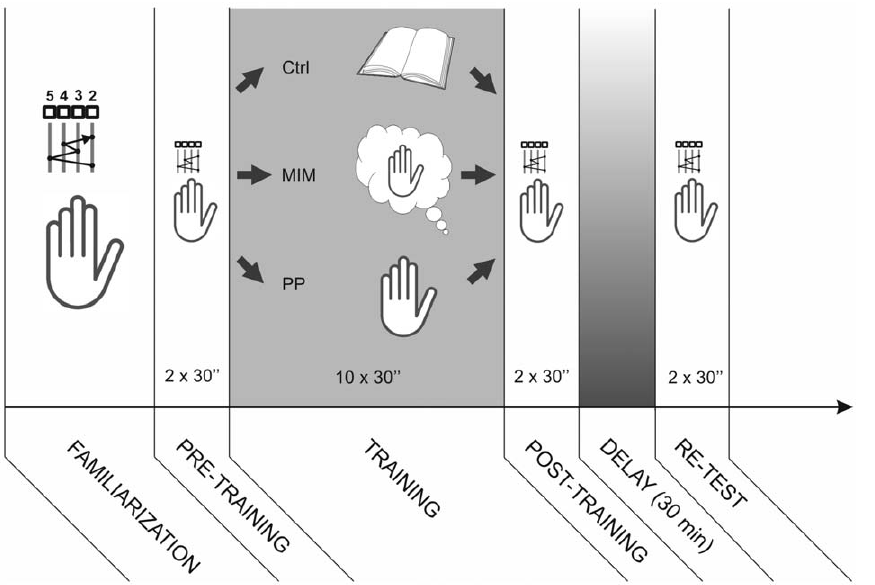
Figure 1. Schematic view of Experiment # 1 protocol. The task consisted of performing a sequential finger tapping with the left hand on a computer keyboard. The experiment was divided into six distinct phases: 1) a familiarization phase, 2) a first pre-training, practice session to evaluate subject performance baseline before learning, 3) a training phase during which 3 different group of subjects (n=8) either physically (PP) or mentally (MIM) performed the sequence (PP) during 10 blocks of 30 seconds, each separated by a 20 second resting period or were engaged in a control (Ctrl) reading task, 4) a first post-training session, 5) a 30 minute delay period, 6) a retest session in order to evaluate the ‘‘early boost’’.